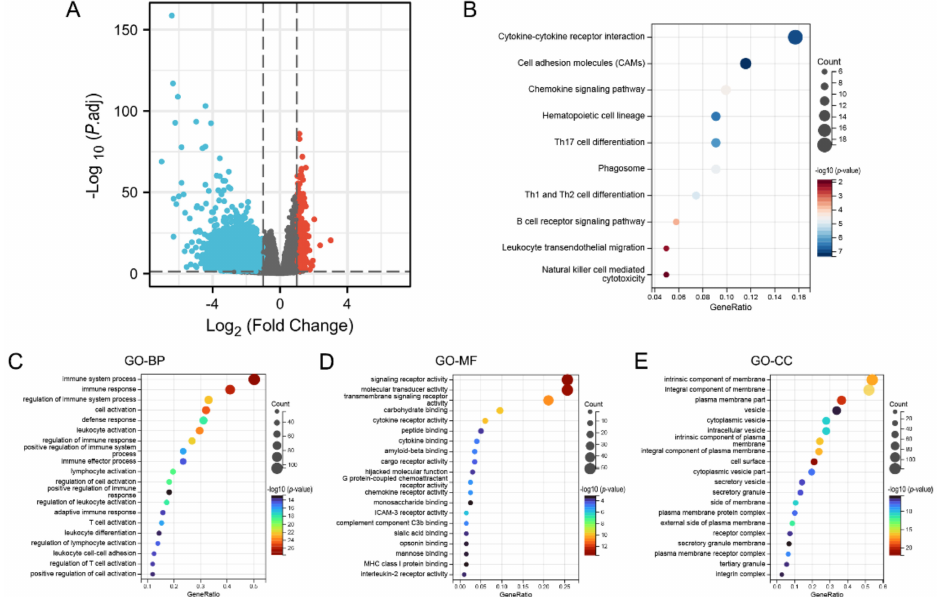
Figure 6. KCNAB2 − related differentially expressed genes (DEGs) and functional enrichment anal- ysis using GO and KEGG. ( A ) Volcano plot of DEGs. Blue and red dots indicate the significantly downregulated and upregulated DEGs. ( B ) Top 10 terms of KEGG analysis of upregulated DEGs. ( C – E ) Top 20 terms of GO analysis of DEGs, including biological process (BP), molecular function (MF), and cellular component